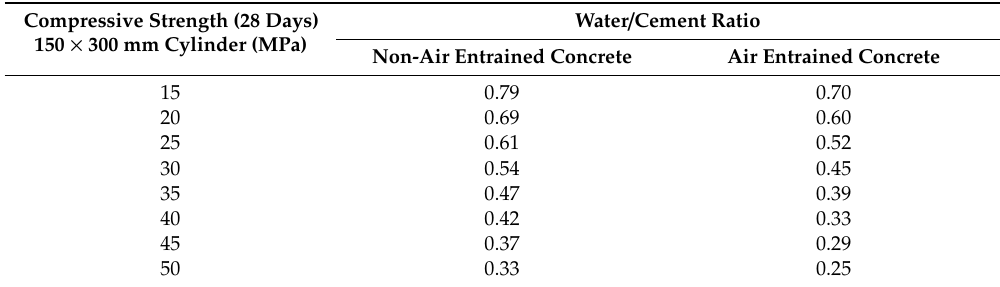
Table 19. Approximate water / cement ratios according to concrete compressive